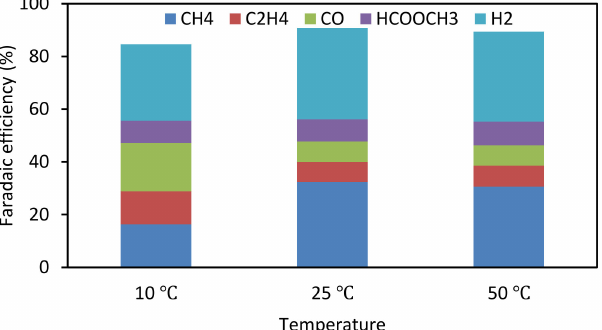
Figure 8. Influence of catalyst preparation temperature on the Faradaic efficiencies of products during the electrochemical reduction of CO 2 at Cu/carbon black electrode. Potential: − 1.9 V, catholyte: 0.15 M of NaCl in methanol.